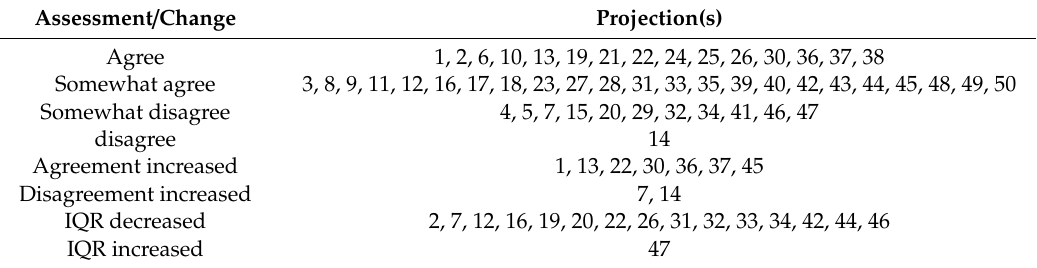
Table 4. Overview of projection assessments and